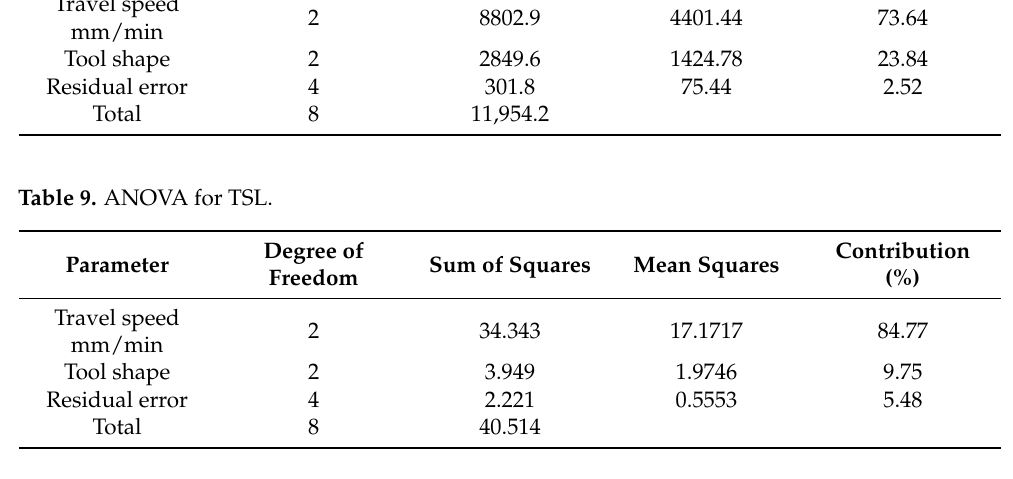
Table 8. ANOVA for Tw.